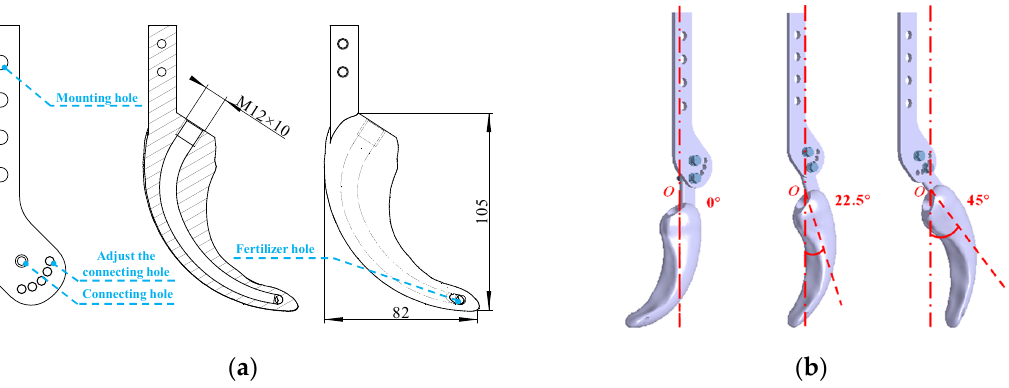
Figure 4. Schematic diagram of bionic liquid fertilizer deep application spray needle and operating angle. ( a ) Schematic diagram of bionic liquid fertilizer deep application spray needle and mounting bracket; ( b ) schematic diagram of operating angle adjustment.